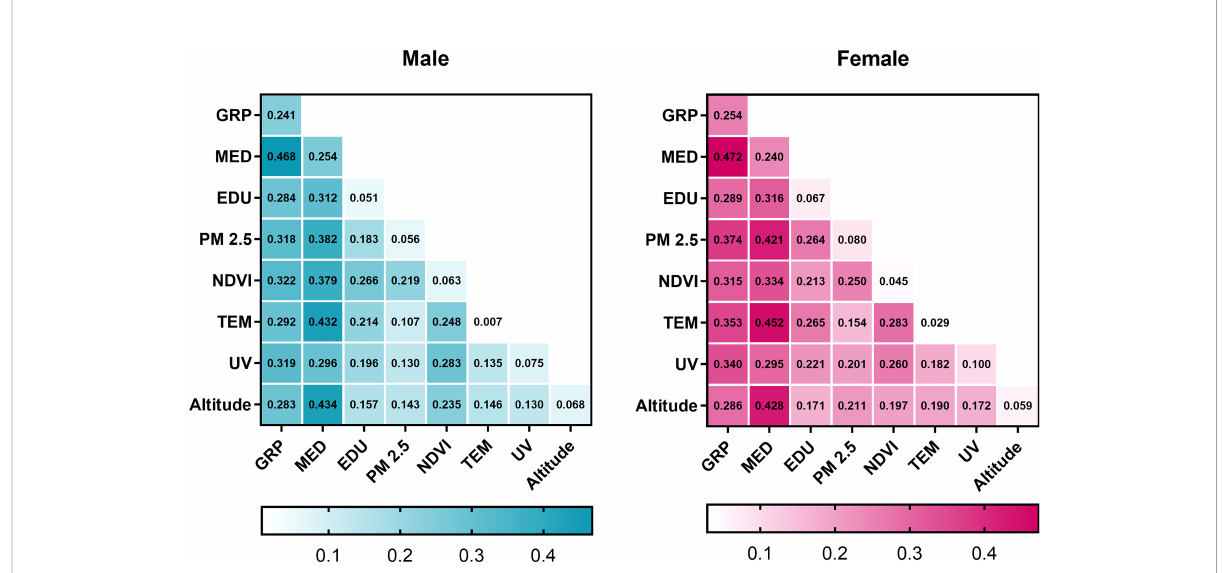
FIGURE 4 Interactive results between paired factors, by sex. Green and magenta colors represent men and women, respectively. The diagonal squares were labeled with independent q value of each factor. The intersection of each row and each column represents the interactive determinant power of paired factors. GRP, gross regional product per capita; MED, medical level; UV, ultraviolet radiation; PM2.5, fi ne particulate matter; EDU, education level; NDVI, normalized difference vegetation index; TEM,